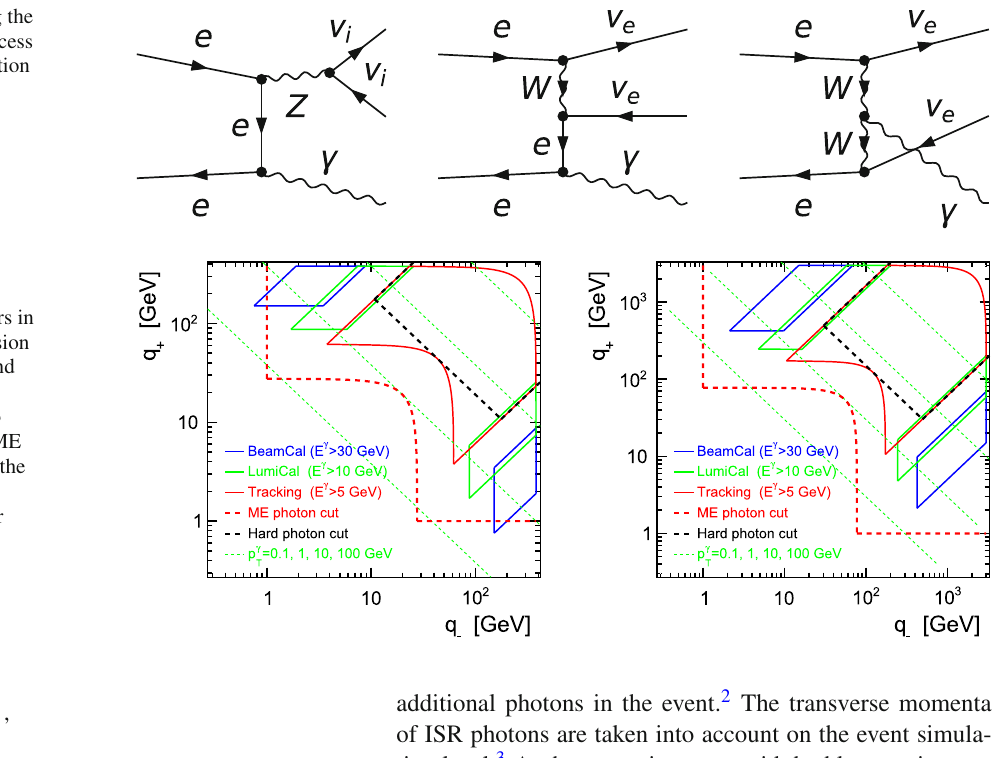
Fig. 3 Detector acceptance expected for the future experiments at e + e − colliders in the ( q + , q − ) plane, for collision energies of 380GeV (left) and 3TeV (right). Dashed lines indicate a default cut used to restrict the phase space for ME photon generation (red) and the cut used for hard photon selection (black), see text for